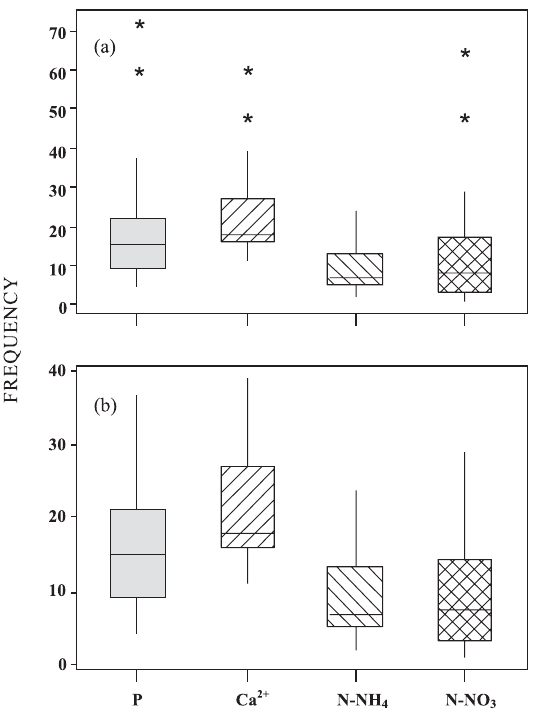
(b).Figure 2. Boxplot of data from the 0–20 cm layer